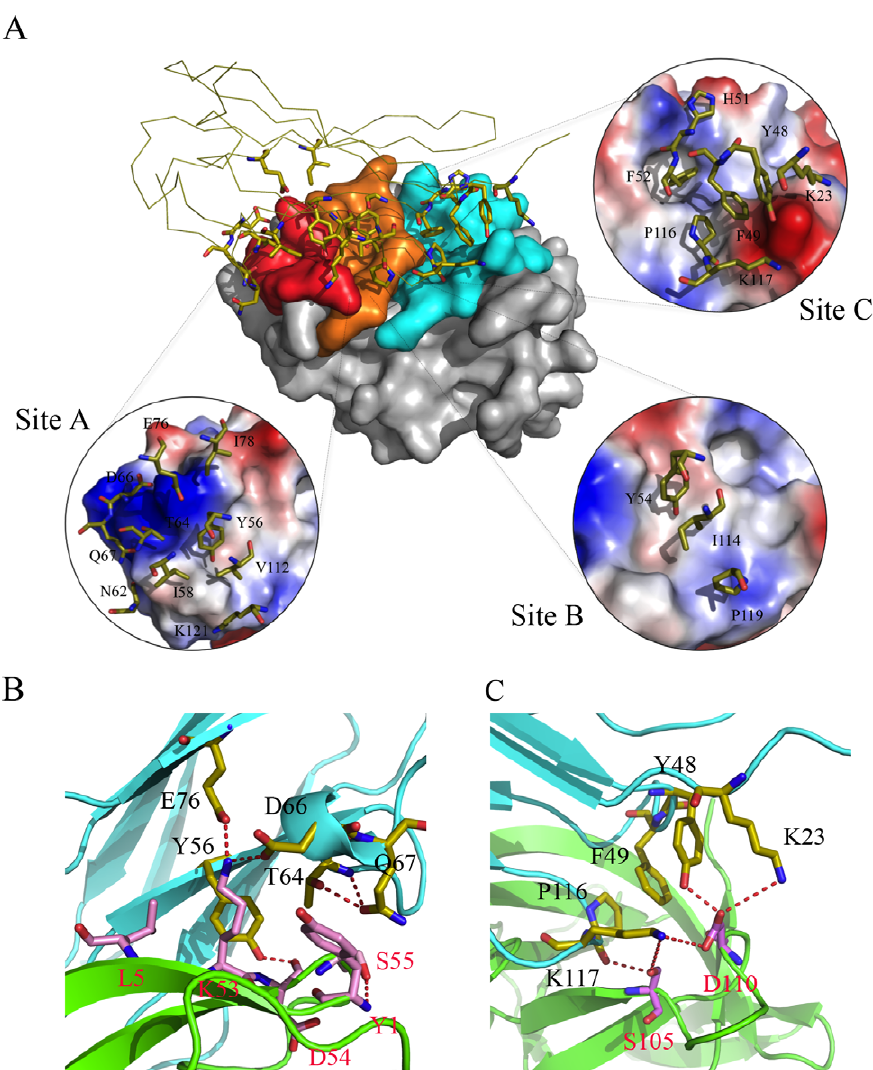
Figure 6. YLDV-IL18BP:IL18 interface. A). Key residues of YLDV-IL18BP at the interface. YLDV-IL18BP binds nearly identical surface of IL18 as previously observed in ECTV-IL18BP inhibitory complex. IL18 is shown as surface representation and colored grey. YLDV-IL18BP is drawn as a ribbon diagram with b -sheets colored in yellow. Binding sites A, B and C on IL18 surface are colored red, orange and cyan respectively. YLDV-IL18BP residues involved in binding IL18 are shown as stick representations. Each insert details the interactions involved in the respective binding site between YLDV- IL18BP and IL18. B). Unique interactions at binding site A. Carbon atoms of YLDV-IL18BP and IL18 are colored in yellow and pink, respectively. The secondary structures of YLDV-IL18BP and IL18 are colored in cyan and green, respectively. Red dashed lines indicate H-bonds. C). Unique